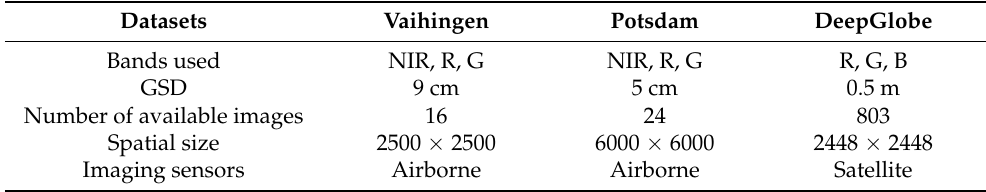
Table 1. Datasets and